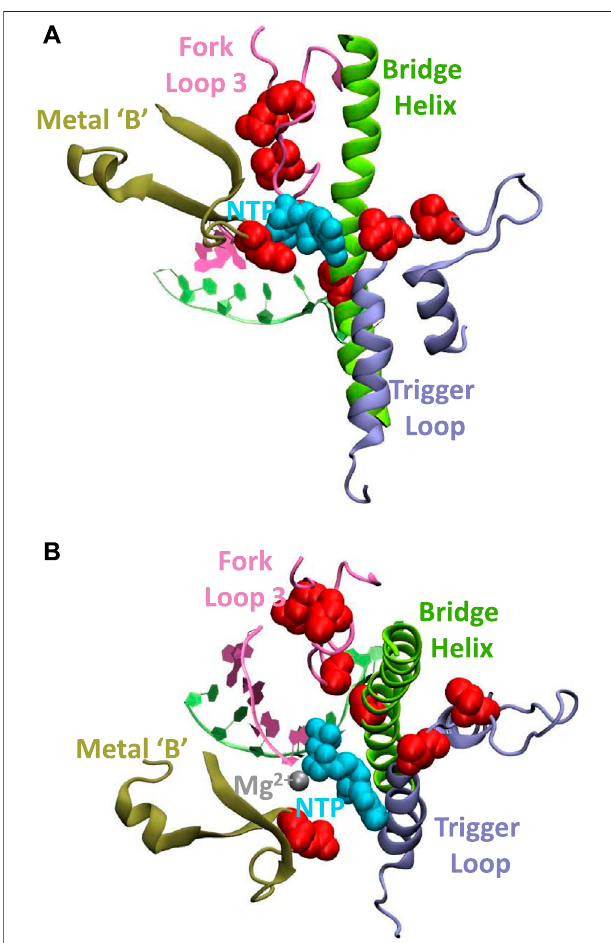
FIGURE2| Spatialarrangementofnanoarchaeal-speci fi csubstitutionswithin thecatalyticsiteofRNAP.TheBridgeHelix(BH)isshowningreen,theTriggerLoop (TL) in blue and Fork Loop 3 (FL-3) in purple. The nucleotide triphosphate is representedasacyanspace- fi llingmodel.Positionssubstitutedin N.equitans are shown as red space- fi lling van der Waals